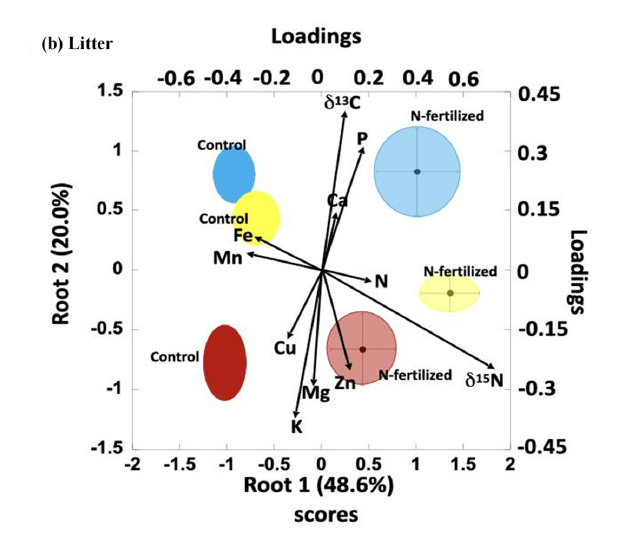
Forests 2021 , 12 , x FOR PEER REVIEW 11 of 17